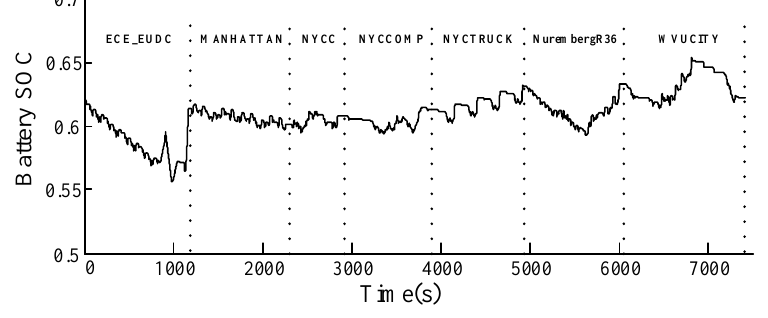
Figure 13. Variation of SOC in the first class of driving cycles. Table 10. Variation of state of charge.